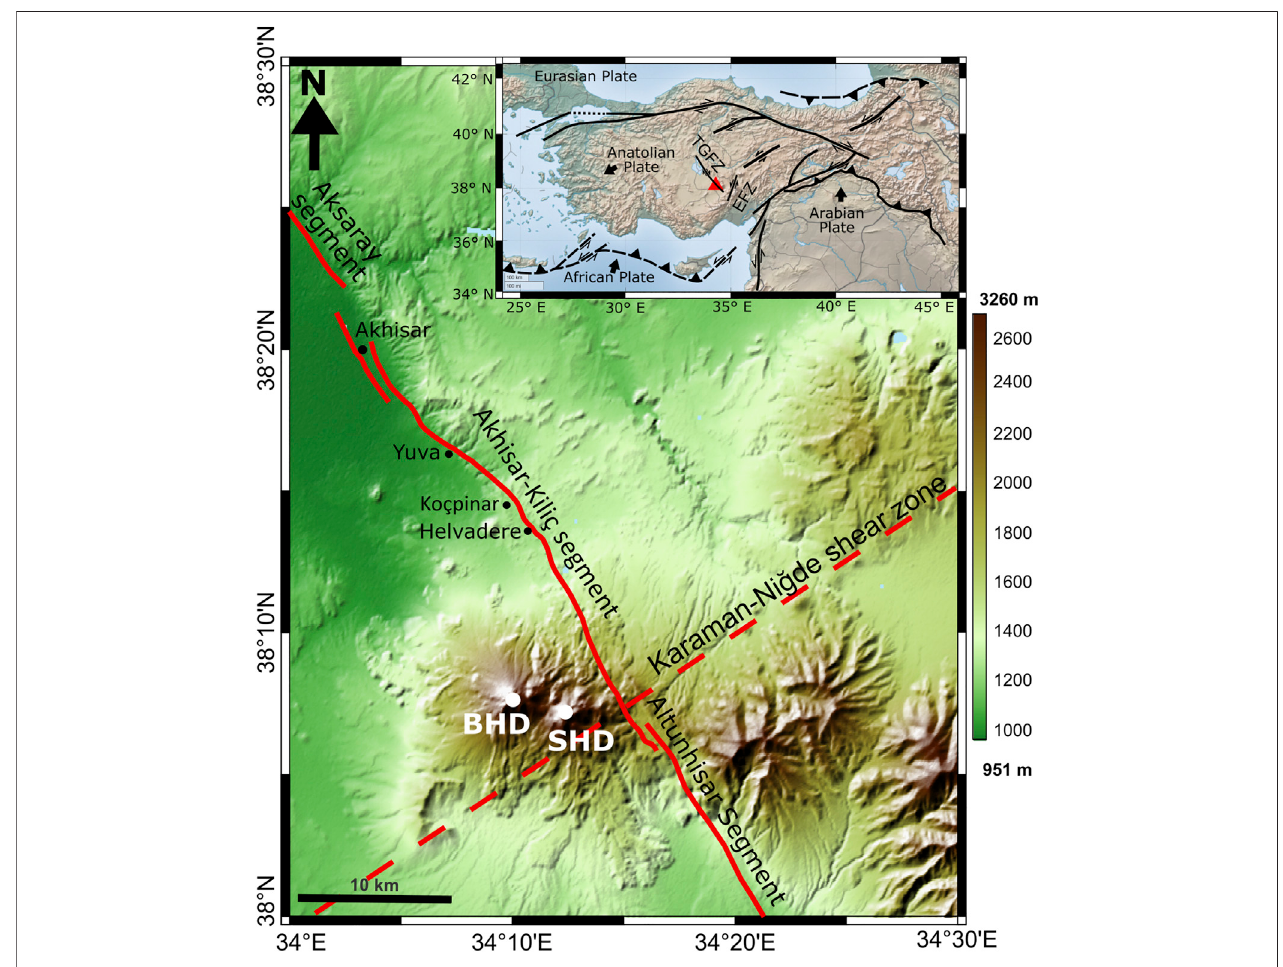
FIGURE 1 | Maps of the study area. Inset: Map of tectonic setting of the Anatolian microplate bound by the Eurasian plate to the north and African and Arabian plates to the south. Large arrows next to plate labels show the overall direction of plate movement. Black lines represent fault zones (EFZ: Ecemi ş fault zone; TGFZ: Tuz Gölü fault zone). The red triangle shows the location of Hasan Da ğ volcano. Fault locations and plate directions are from Tosun et al. (2007). Main panel: solid red line: Akhisar-Kiliç fault segment of the TGFZ; dashed red line: approximation of the Karaman-Ni ğ de shear zone; BHD: Big Hasan Da ğ ; SHD: Small Hasan Da ğ .